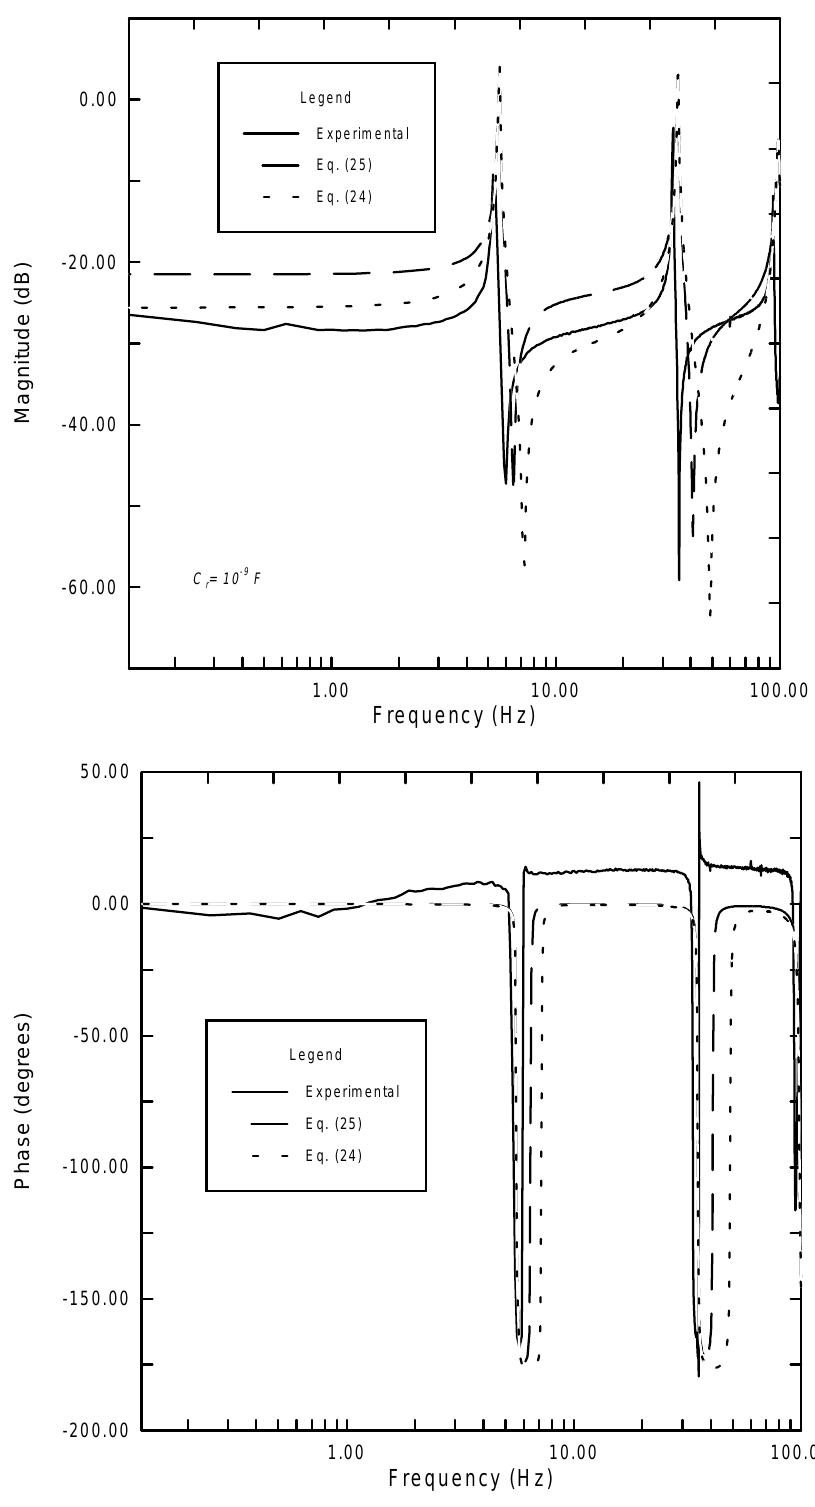
Fig. 9. Experimental and numerical transfer